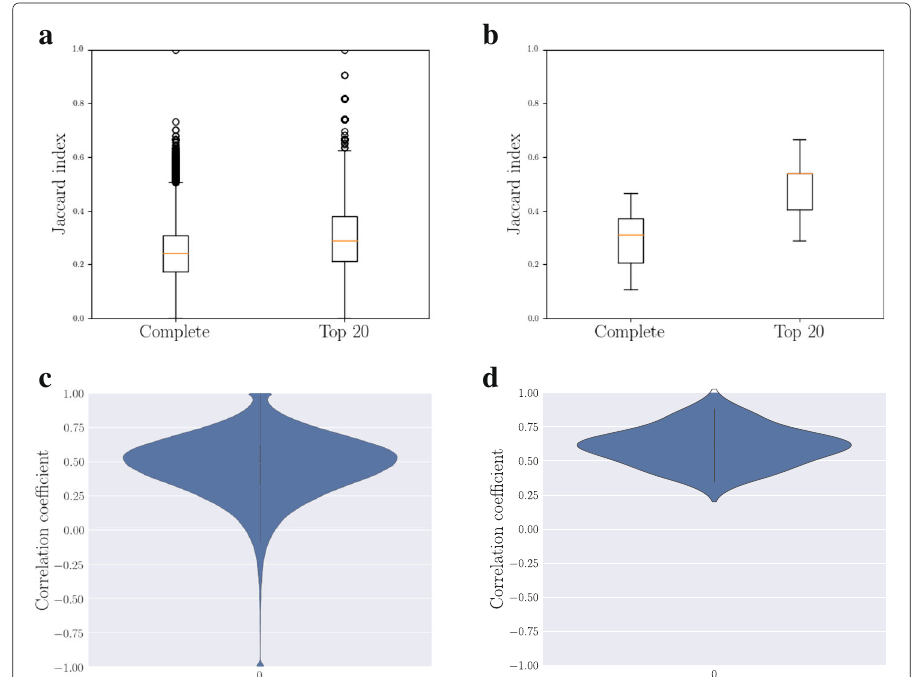
Fig. 4 Channels are Different in the Membership and Ranking of Alters. Although the shapes of call and text signatures of an ego are relatively similar to each other, the egocentric networks formed through different channels are different in the membership and ranking of alters. The distribution of Jaccard indices between the sets of call and text alters are shown in a for DS1 and b for DS2. The distribution of correlation coefficients between call ranks and text ranks of those alters who are in both networks is shown in c for DS1 and in d for DS2. Alters who are only in one of the networks are not